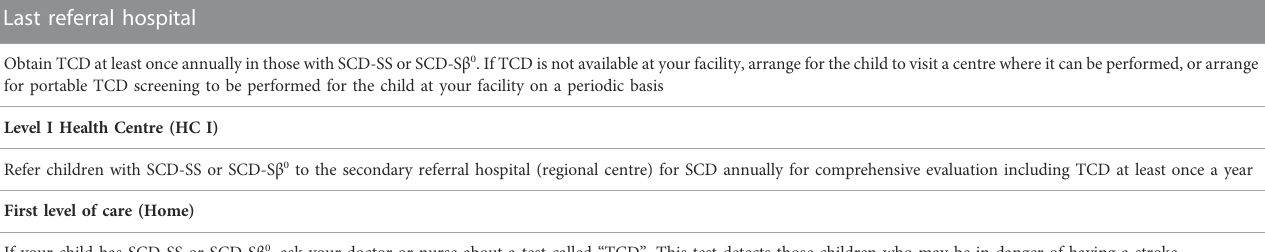
TABLE 5 Screening for stroke risk. Transcranial Doppler ultrasonography (TCD) for children at different levels of healthcare facilities. Last referral